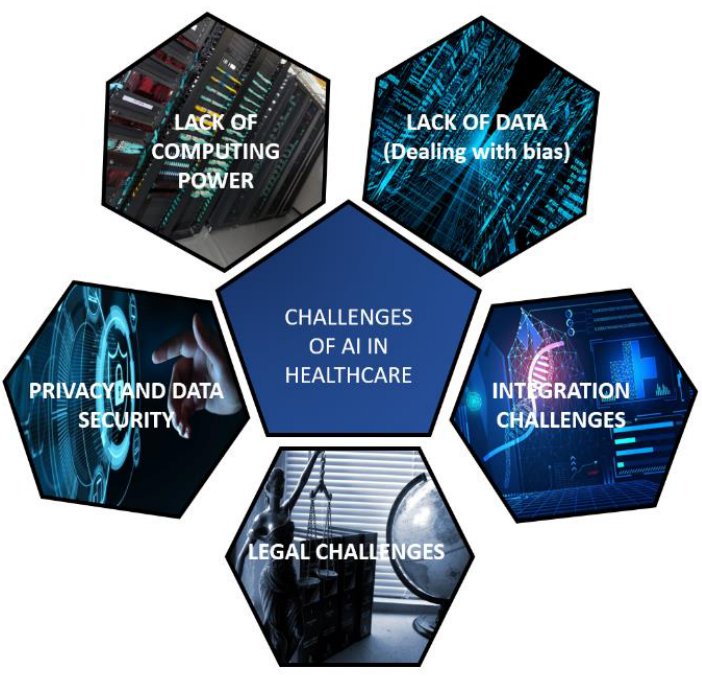
Figure 9. Key Challenges of AI in Healthcare.